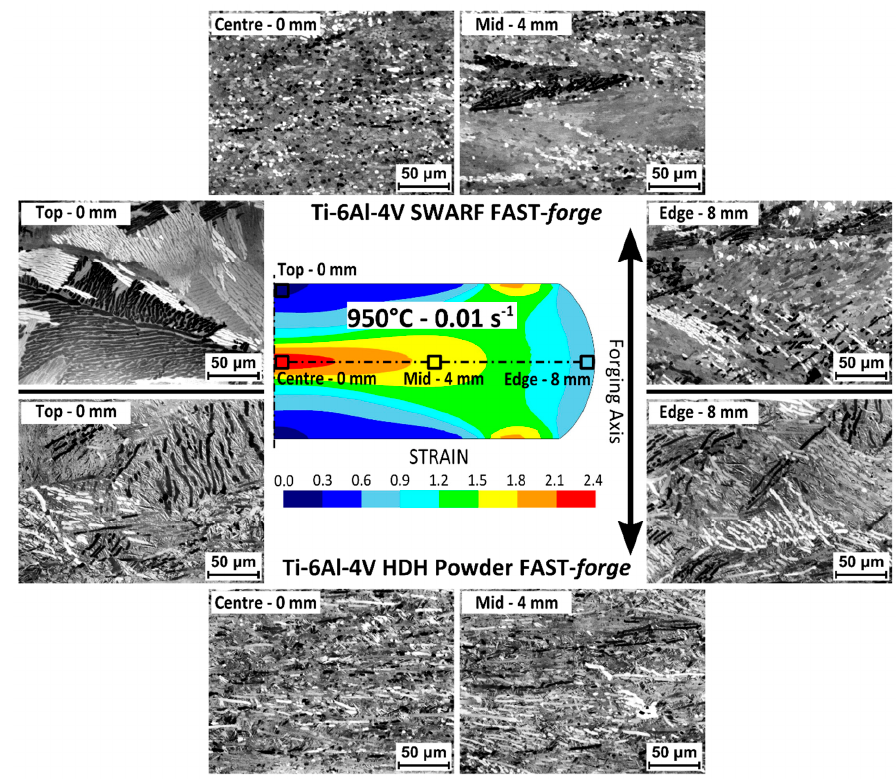
Figure 11. Cross-polarized light micrographs of the microstructural evolution with increasing strain from the top/edge to the centre of a specimen after hot compression at 950 °C and 0.01 s − 1 ; test specimens were produced from Ti-6Al-4V swarf consolidated via FAST ( top ) and Ti-6Al-4V HDH powder consolidated via FAST ( bottom ).